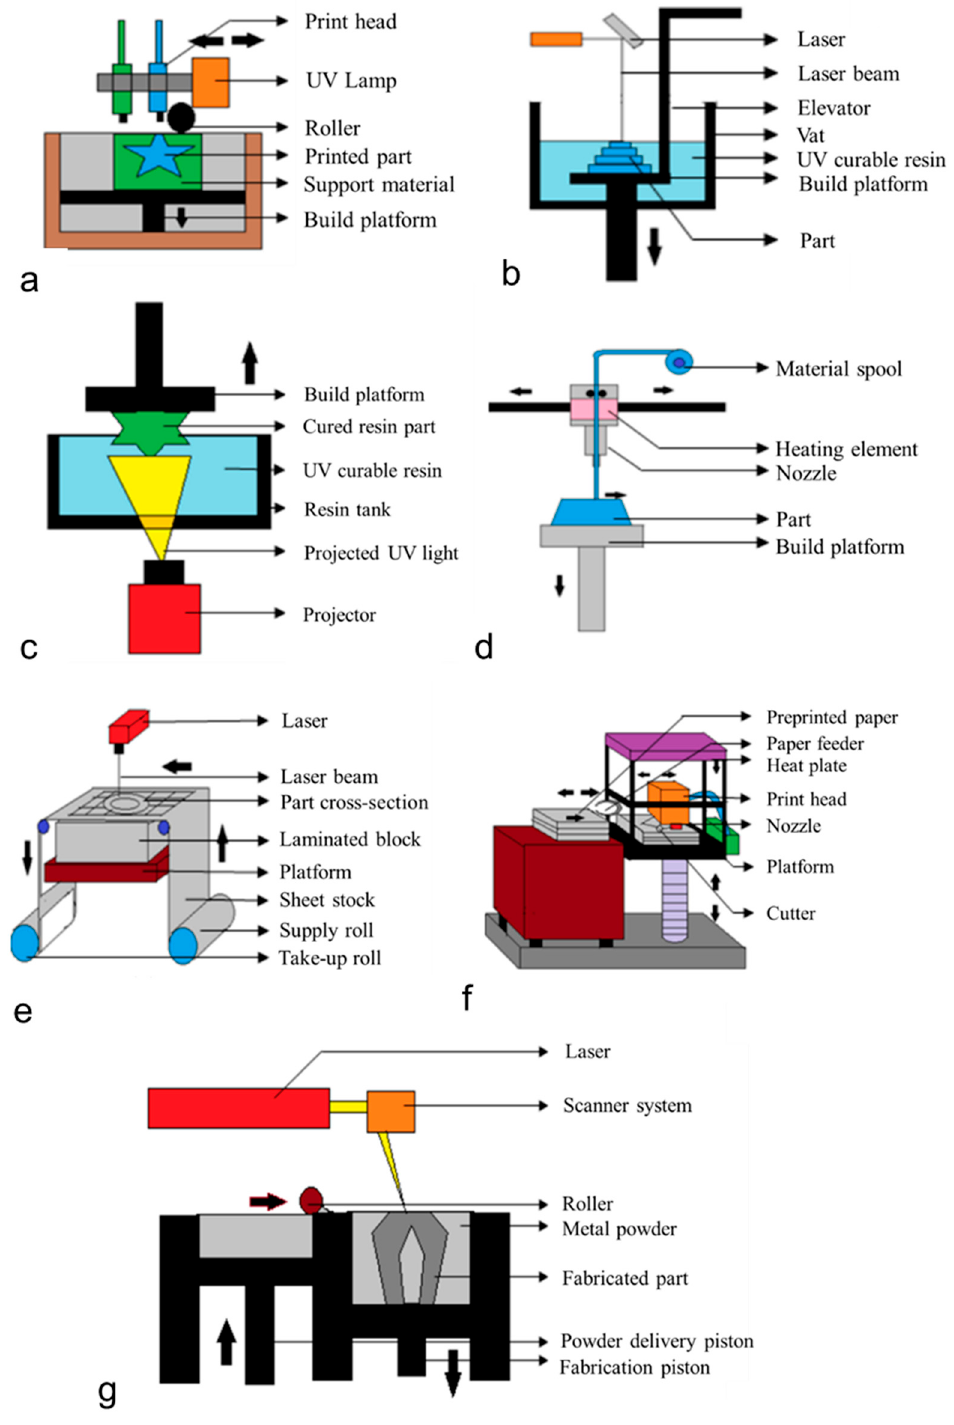
Figure 1. Schematic diagram of popular additive manufacturing processes: ( a ) PolyJet printing; ( b ) stereolithography (SLA); ( c ) direct light processing (DLP); ( d ) fused deposition modeling (FDM); ( e ) laminated object manufacturing (LOM); ( f ) selective deposition modeling (SDM); ( g ) selective laser sintering (SLS) [1].